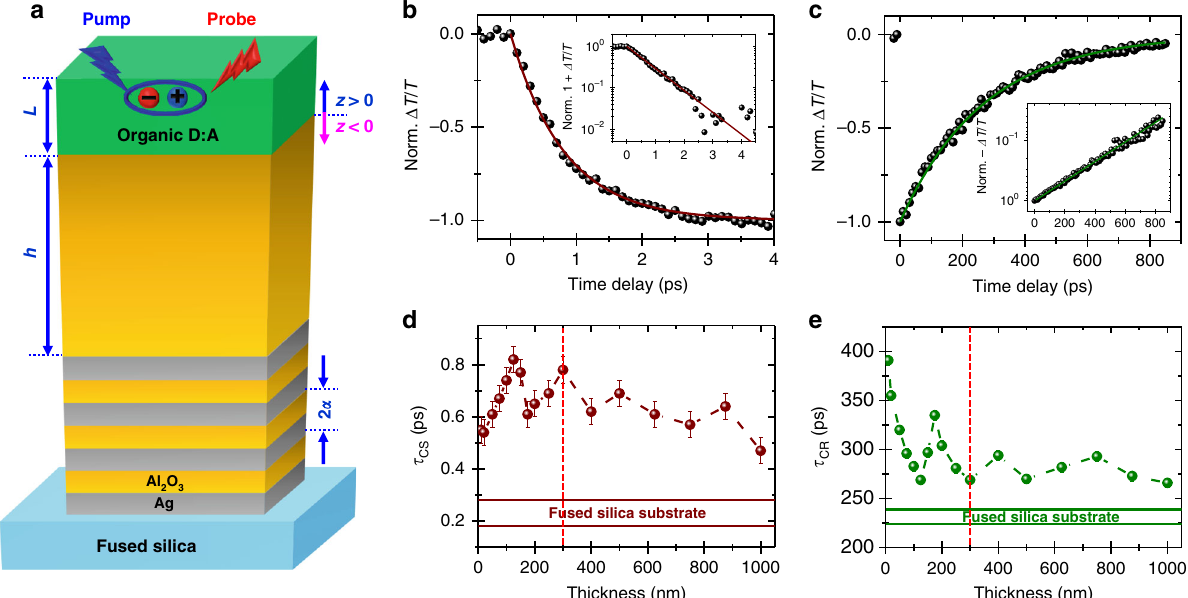
Fig. 1 Composite nanostructure and transient absorption data. a Schematic representation of the Ag-Al 2 O 3 composite nanostructure covered by an organic dyad fi lm with their characteristic parameters: number of pairs ( p ), pair thickness and periodicity (2 a = 20 nm), metal volume fraction ( f v = 0.5), Al 2 O 3 top-thickness ( h ), distance from the Al 2 O 3 -Donor:Acceptor (D:A) molecules interface ( z ), and dyad- fi lm thickness ( L = 40 nm). b , c Normalized relative transmittance variation for charge separation and charge recombination, respectively, as a function of the time delay with a 125-nm-thick Al 2 O 3 composite nanostructure top-cover (inset: semi-log scale of 1 + Δ T / T , and - Δ T / T , note that to illustrate the signal variation the scales in the inset are inverted), respectively. Colored lines are exponential fi ts. d , e Charge separation (CS) and charge recombination (CR) dynamics as a function of the thickness of the Al 2 O 3 composite nanostructure top-cover; the horizontal straight lines correspond to the charge transfer dynamics and their uncertainties measured on reference fused silica substrates. All the measurements were completed in transmittance mode, with a 325-nm photo-excitation and a 725 nm-probe beam. τ τ Table. 1 Characteristic times. CS and CR are inversed, for instance, ~125, 175, and 300 nm, with the latter, materialized by red dashed vertical lines, but do not compensate one another, as displayed in Fig. 2a. Noticeably, the modulation amplitude decreases as the donor:acceptor fi lm is further away from the nearest metal – Al 2 O 3 interface (Fig. 1d and e, Fig. 2a). Overall, when compared to fused-silica data, charge separation, and recombination on top of composite nanostruc- tures varied by a maximum factor of 3.7 and 1.7, respectively. They correspond to spacer thicknesses of 125 nm and 10 nm, with the ratios of 0.85 ps to 0.23 ps and 391 ps to 226 ps, as shown in Table 1. When comparisons are completed between kinetics obtained on composite nanostructures, these factors reach ~1.57 and ~1.44, corresponding to relative variations of 57% and 44%, respectively. This charge-separation-maximum variation is obtained between spacer thicknesses of 125 nm (0.85 ps) and 10 nm (0.55 ps), while this charge-recombination maximum is observed between spacer thicknesses of 10 nm (391 ps) and for 300 nm (269 ps).